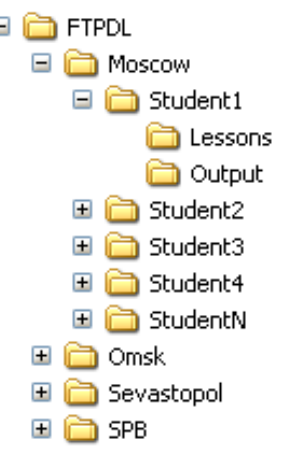
Figure 3. Structure of the main project folder